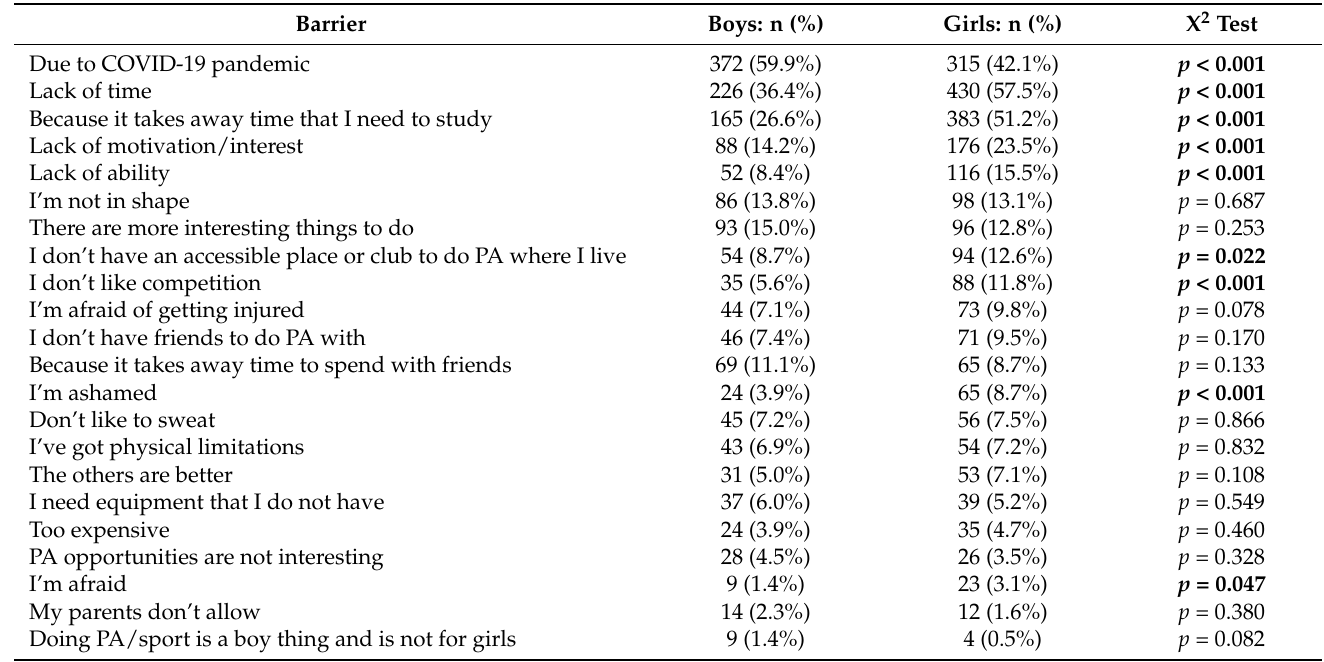
Table 2. PA barriers stratified by sex.